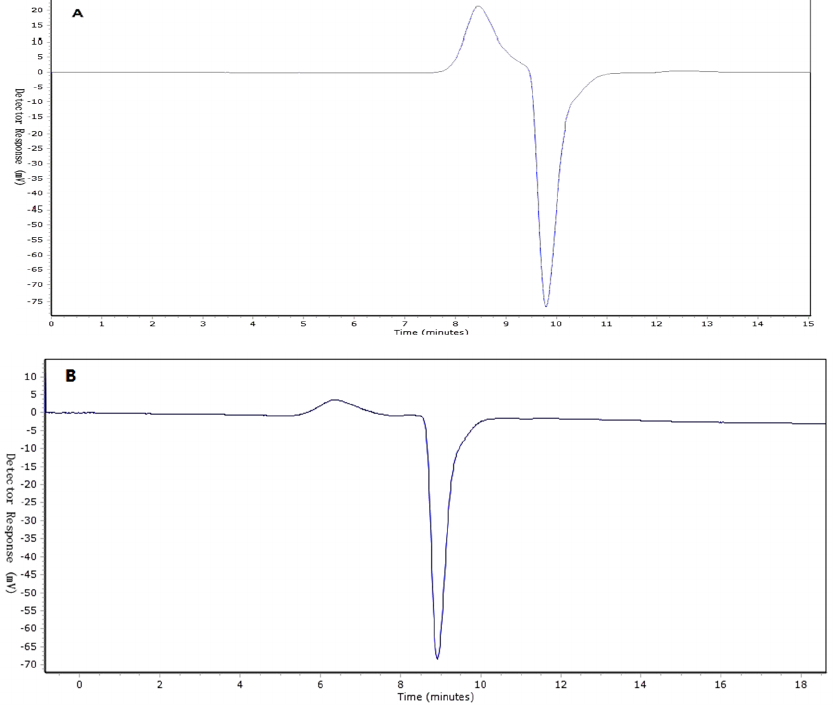
Figure 1. ( A ) The gel permeation chromatography (GPC) of I. obliquus crude polysaccharide (IOEP1); ( B ) the GPC of IOEP2.